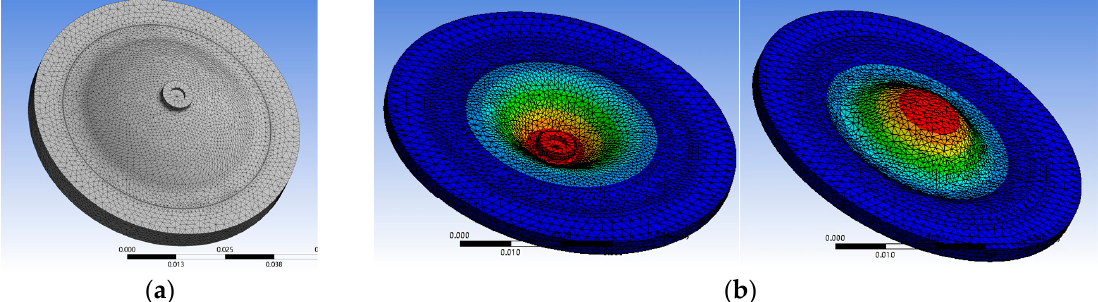
Figure 2. Numerical model of the diaphragm ( a ) the model mesh with a diaphragm thickness of B 0 = 6 mm and ( b ) the total deformation of the diaphragm with a thickness of B 0 = 4 mm.